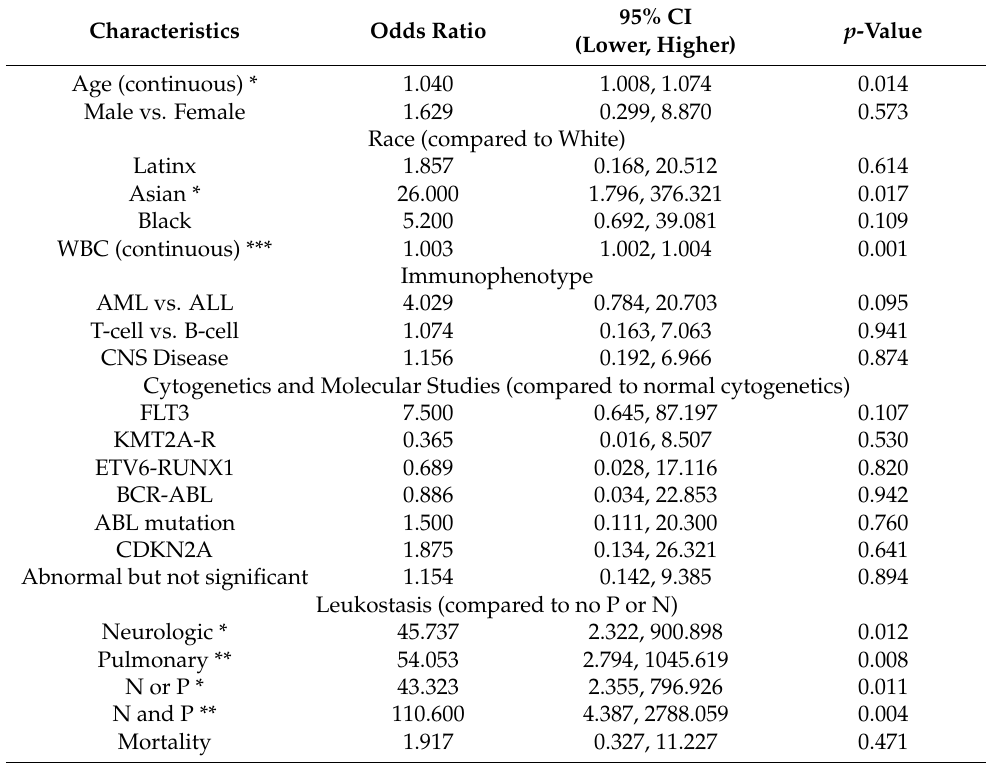
Table 3. Patient characteristics as predictors of the odds of undergoing